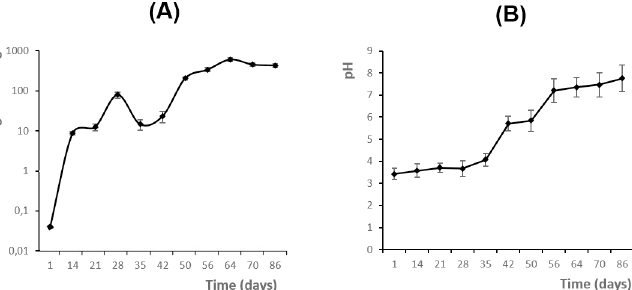
Fig 1. Abundance of Aspergillusfumigatus (A) and measured pH values of orange-based compost (B) during the composting process. Both analyses were done during 10 sampling periods. Points represent mean values, and error bars show standard